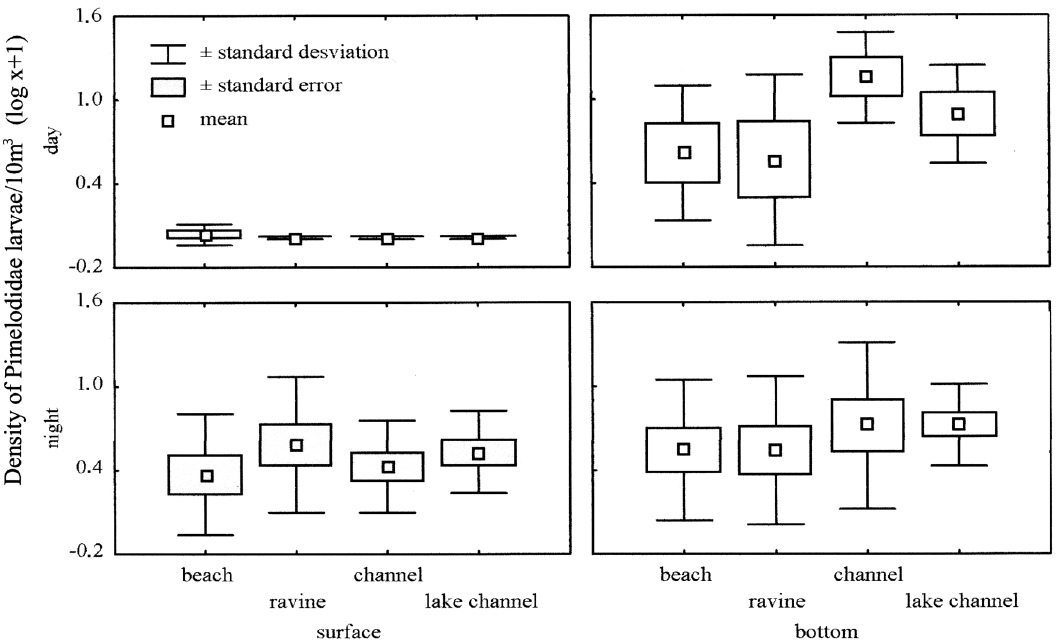
Fig. 4. Abundance of Pimelodidae larvae in different microhabitats in the surface and bottom in the Anavilhanas Ecological